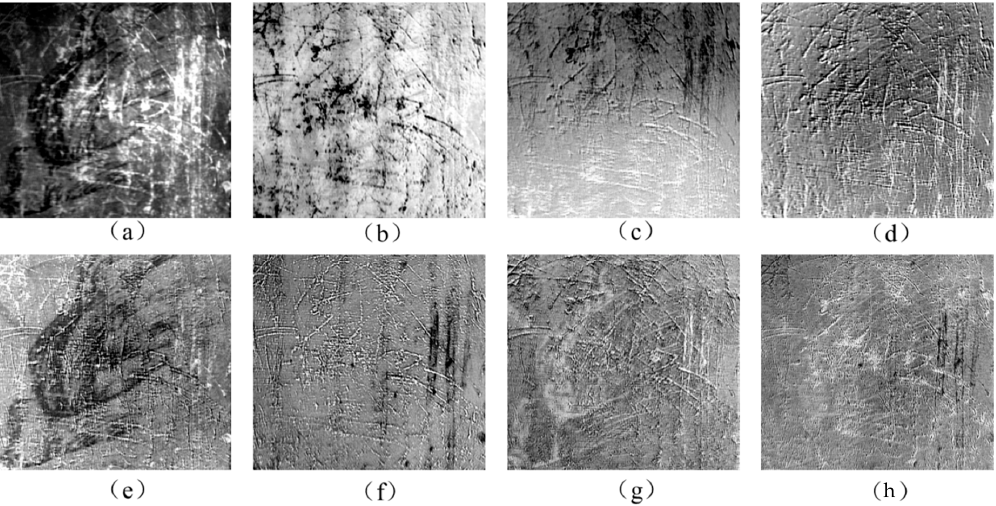
Figure 3. The first 8 bands of area 1 obtained by MNF transform. ( a ) MNF band 1; ( b ) MNF band 2; ( c ) MNF band 3; ( d ) MNF band 4; ( e ) MNF band 5; ( f ) MNF band 6; ( g ) MNF band 7; ( h ) MNF band 8.